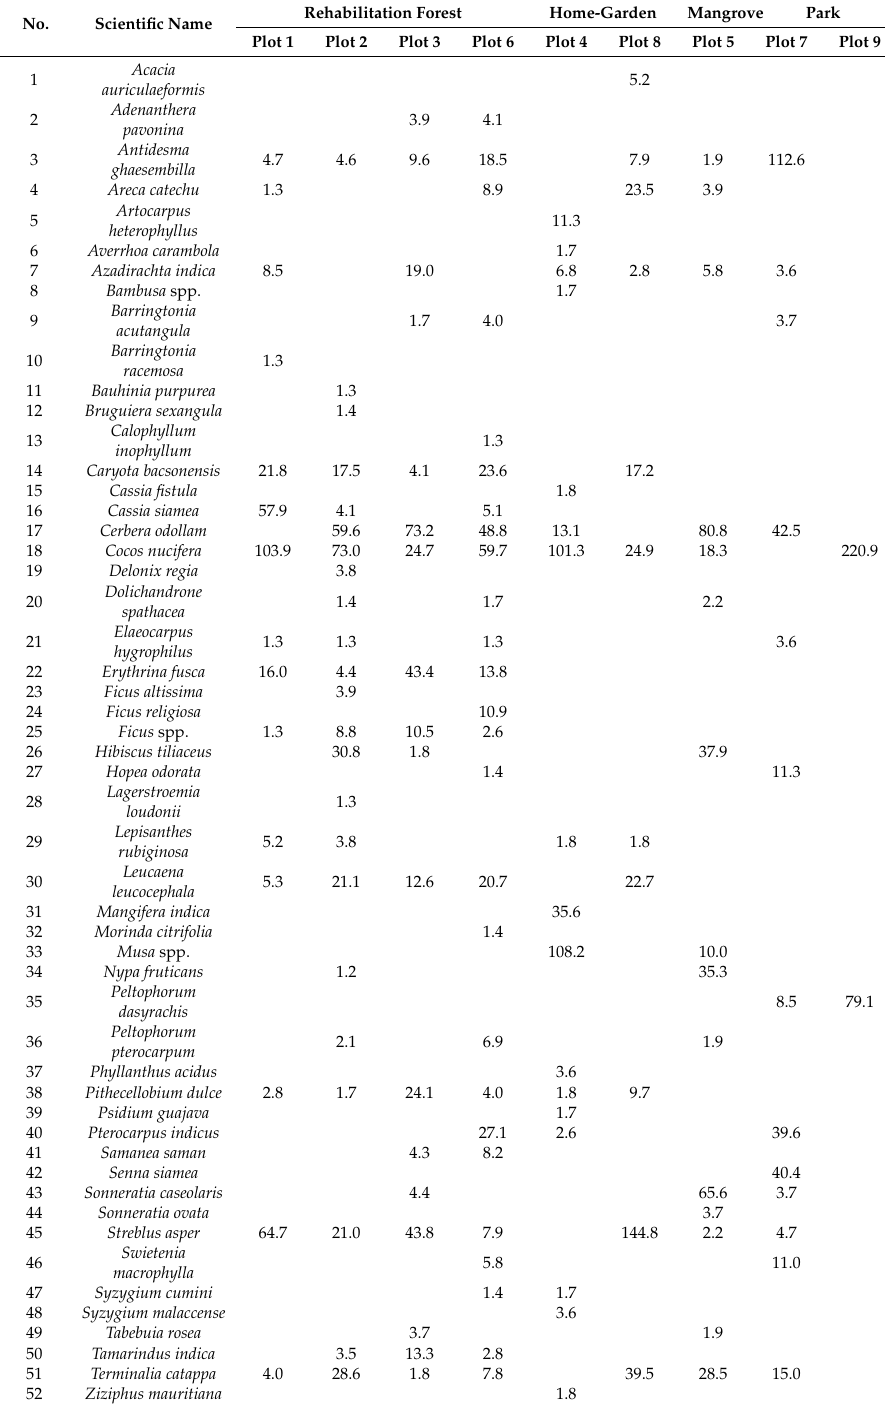
Table 2. Frequency and importance value index (IVI) of tree species in each plot within Bang Kachao Green